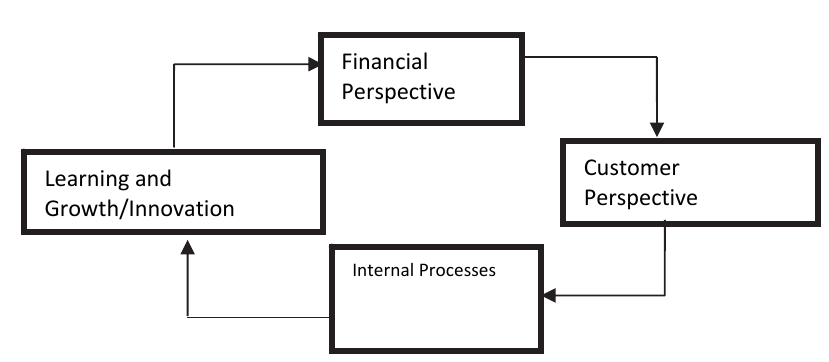
Figure 5: The four perspectives of a Balance Score Card